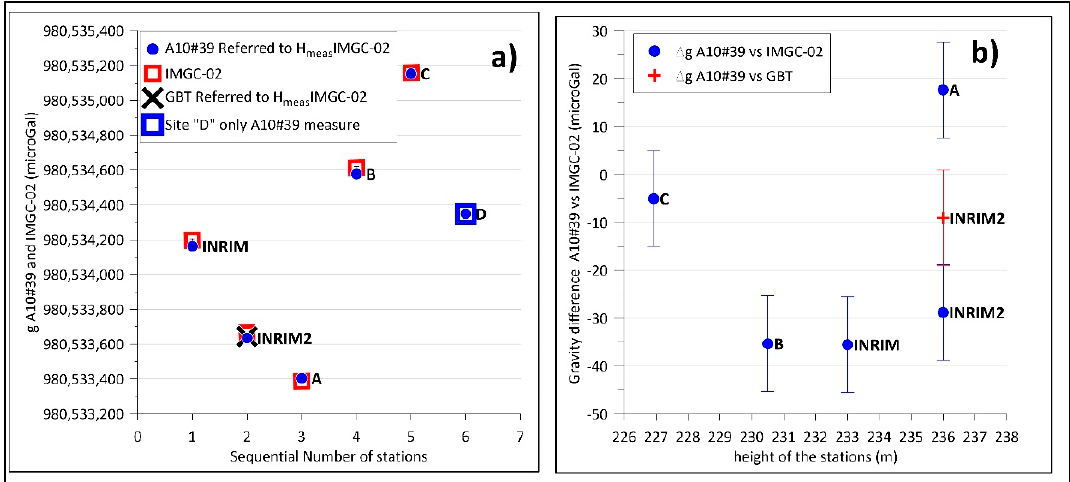
Figure 2. ( a ) gravity difference between A10#39 and IMGC-02 gravimeters at the 5 stations at the INRiM Laboratories. The value at the new station “D” and that measured with the GBT gravimeter at the INRIM2 point are also shown. Error bars are within the symbols size; ( b ) gravity differences between A10#39 and IMGC-02 values, all referred to the same height of IMGC-02 measure, at the 5 stations. The difference A10#39 versus GBT is also shown.